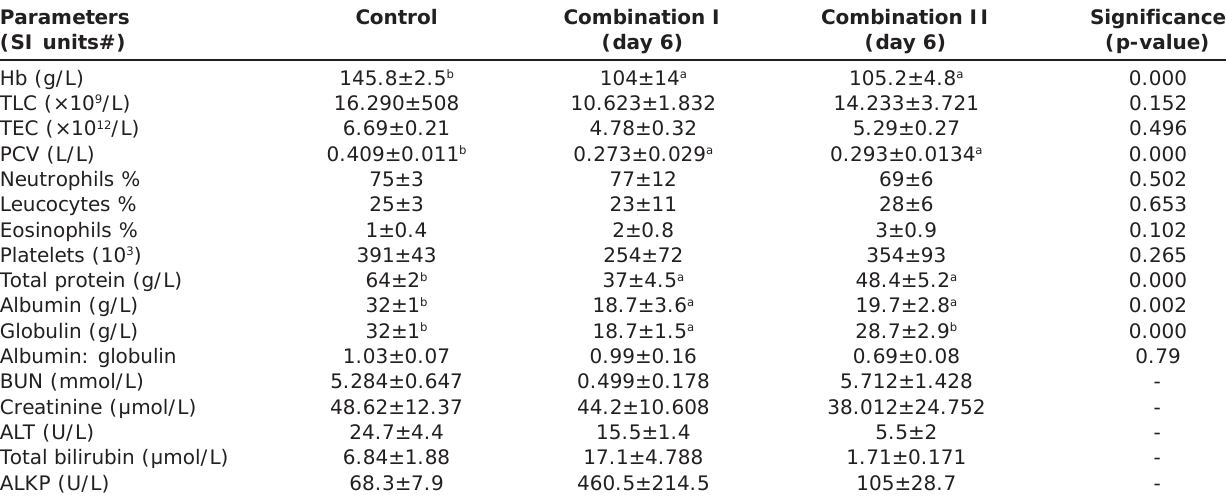
Table-2: Comparison of hemato-biochemical alterations after administering combination I and II therapy with control group (mean±SE). Parameters (SI